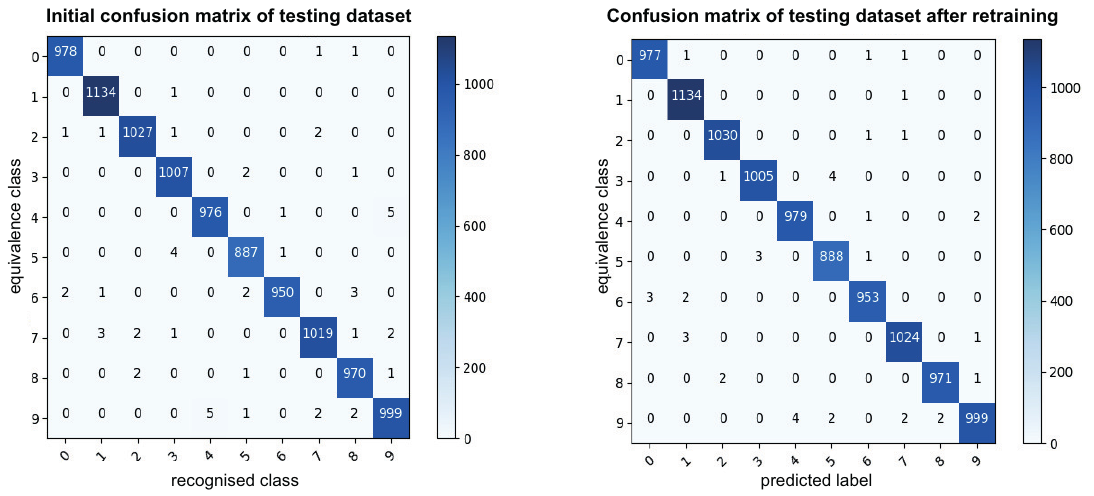
Figure 8. Confusion matrices comparing the performance of the initial and second training on the testing dataset.